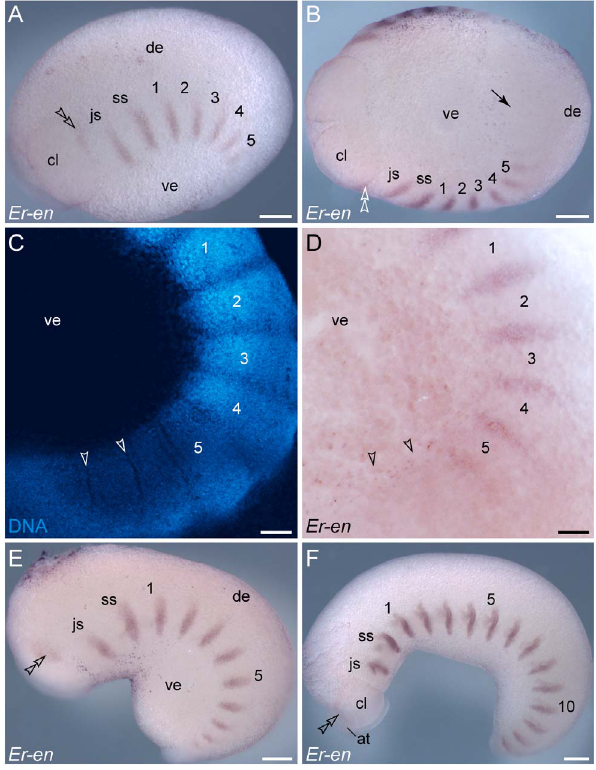
Figure 3. Expression of engrailed in embryos of the onychophoran E. rowelli at subsequent developmental stages. Anterior is left in A, B, E, F and up in C, D. Leg-bearing segments and corresponding limbs are numbered. Note the repeated stripes along the body and the lack of expression in the dorsal and ventral extra-embryonic tissue. Double-arrowheads in A, B, E and F indicate the dorsally located domain of engrailed in the cephalic lobe. Arrowheads in C and D point to the transverse ectodermal furrows, which lack engrailed expression. (A) Early stage II embryo in lateral view. (B) The same embryo as in A in ventral view. Note the lack of expression in the posterior region and around the proctodaeum (black arrow). (C) Confocal micrograph of the posterior end of the same embryo as in A labelled with the DNA marker SYBR Green. (D) Light micrograph of the same embryo as in C. (E) Early stage III embryo in lateral view with eleven engrailed stripes along the body and a spot-shaped domain in the developing antenna (arrowhead). (F) Late stage III embryo in lateral view with 15 engrailed stripes along the body (13 within the trunk) and an additional domain in the developing antenna (arrowhead). Abbreviations: at , developing antenna; cl , cephalic lobe; de , dorsal extra-embryonic tissue; js , jaw segment; ss , slime papilla segment; ve , ventral extra-embryonic tissue. Scale bars: 250 m m (A, B, E, F), 100 m m (C, D).